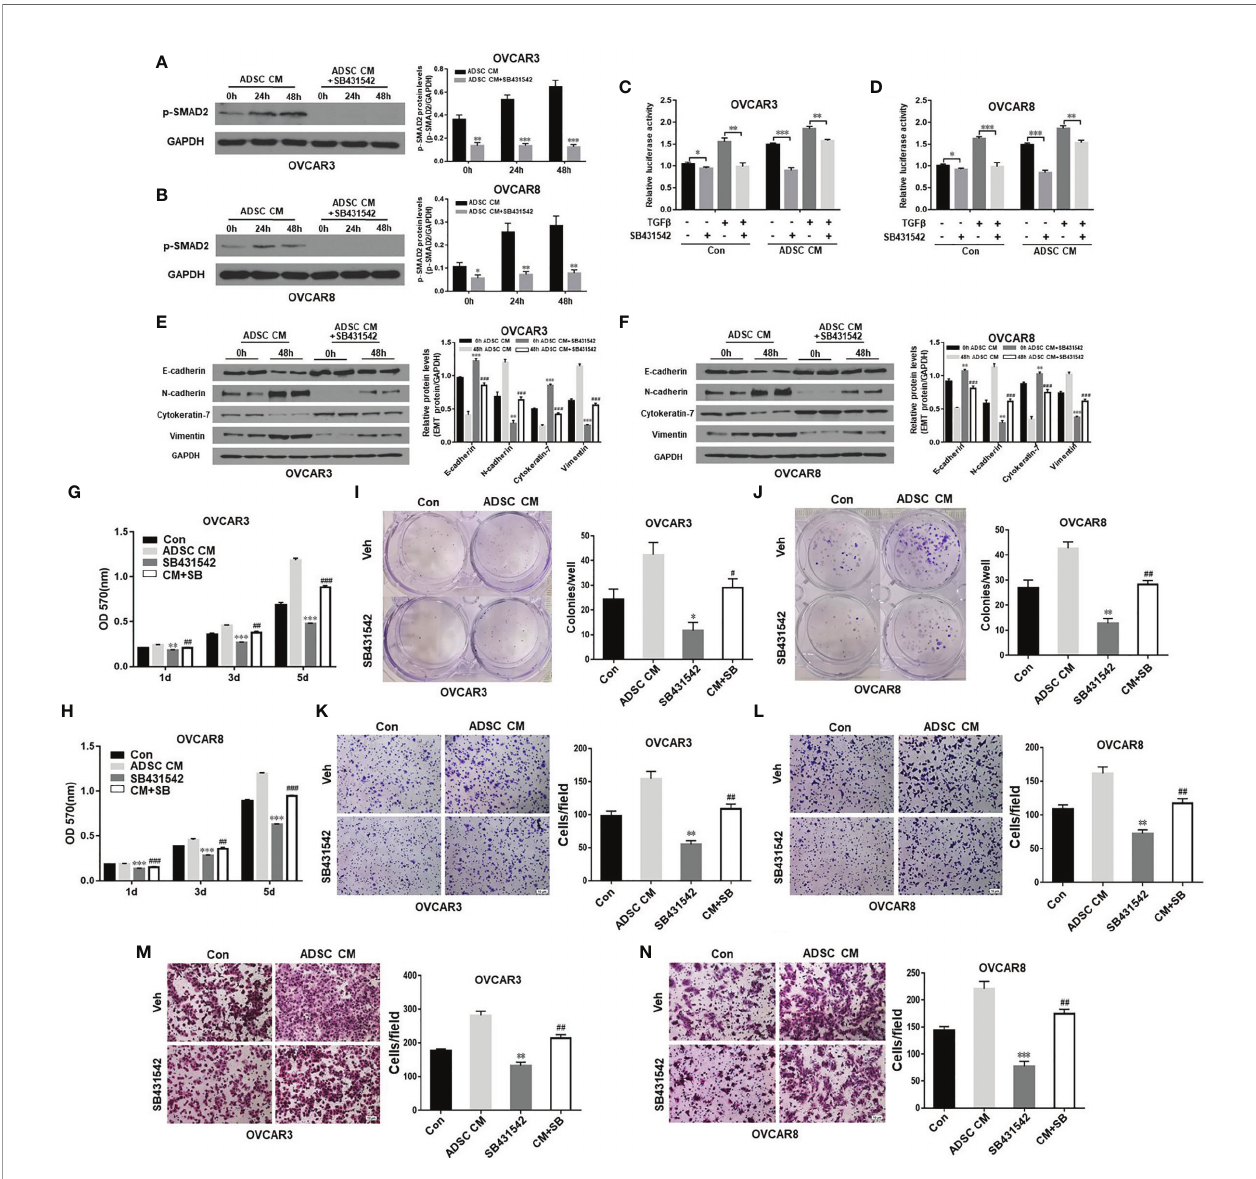
FIGURE 3 | Inhibition of TGF- b pathway antagonizes ADSC-induced OC growth, migration, and invasion. (A, B) Western blot analysis of the p-SMAD2 expression in both OVCAR3 (A) and OVCAR8 (B) cells treated with 10 m M SB431542 for 24 h and then ADSC-CM for different time durations. Right, the quanti fi cation analysis of the blots. (C, D) Luciferase activity in OVCAR3 (C) and OVCAR8 (D) cells following ADSC-CM treatment for 24 h, SB431542 treatment for 24 h, then 6 ng/ml TGF- b treatment for 12 h. (E, F) Western blot analysis of EMT markers in both OVCAR3 (E) and OVCAR8 (F) following treatment with ADSC-CM and SB431542 (10 m M) for 48 h. Right, the quanti fi cation analysis of the blots. (G, H) MTT assay was performed to detect the cell proliferation ability of OVCAR3 (G) and OVCAR8 (H) cells at different time points following ADSC-CM and SB431542 (10 m M) treatment. (I, J) Cell colony formation assay determined cell survival in OVCAR3 (I) and OVCAR8 (J) cells following ADSC-CM and SB431542 (5 m M) treatment. (K , L) Cell migration in OVCAR3 (K) and OVCAR8 (L) cells treated with ADSC-CM or control medium following SB431542 (10 m M) treatment 24 h performed using Transwell plates. (M, N) Cell invasion in OVCAR3 (M) and OVCAR8 (N) cells treated with ADSC-CM or control medium following SB431542 (10 m M) treatment for 24 h using Matrigel-coated plates. Data represent the mean ± SD of three independent experiments. * p < 0.05, ** p < 0.01, *** p < 0.001 compared with the corresponding control group; # p < 0.05, ## p < 0.01, ### p < 0.001 compared with the corresponding ADSC-CM